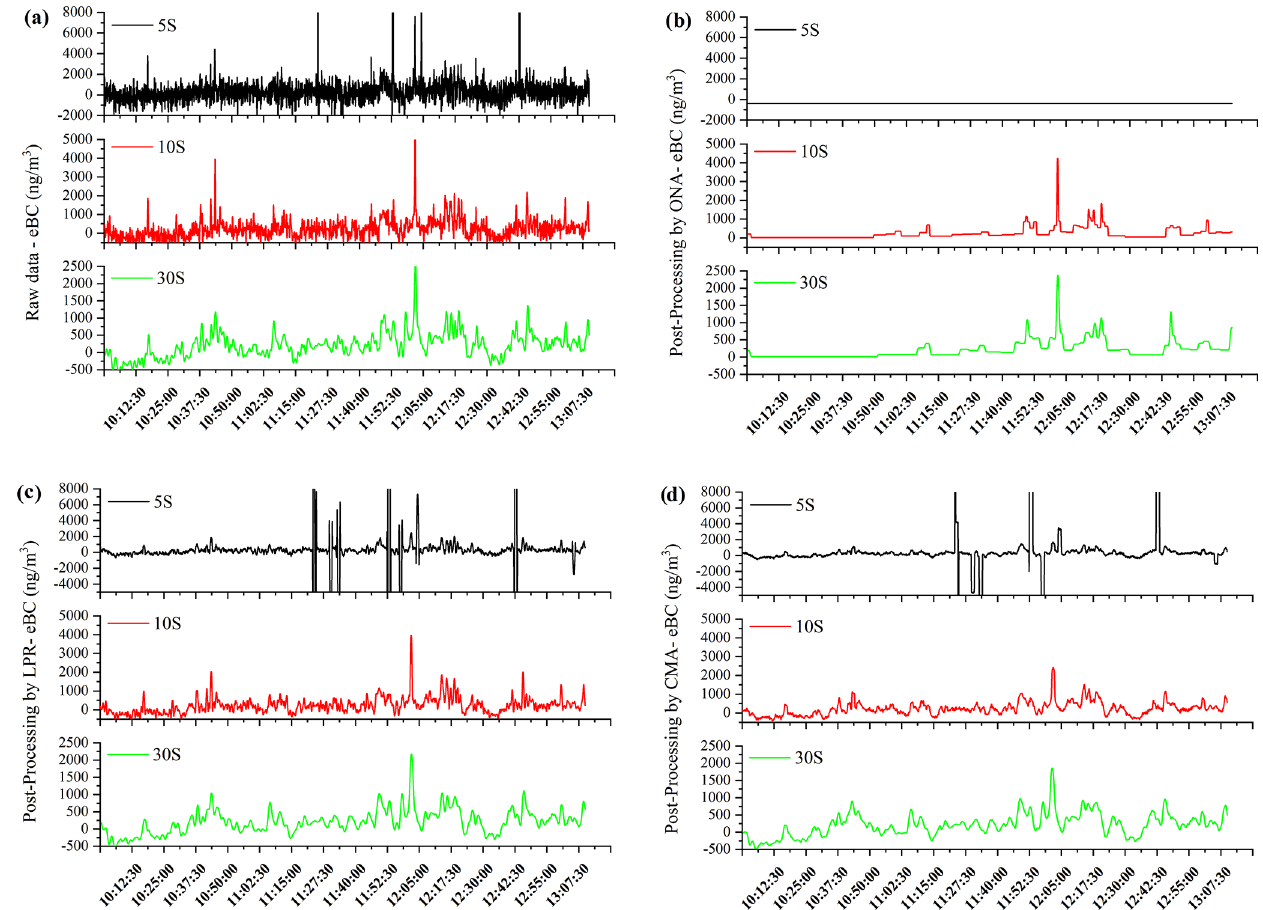
Figure 1. The temporal fluctuations of the black carbon levels measured with the MA200 at sampling time bases of 5, 10, and 30s during a typical sampling period (about 190min); (a) raw data without noise reduction; (b) data treated with optimized noise reduction averaging; (c) data treated with local polynomial regression; and (d) data treated with centred moving average. The analysis was carried out on data streams from three MA200 devices all collected during a single sampling run (measurements 5, 6, and 7).